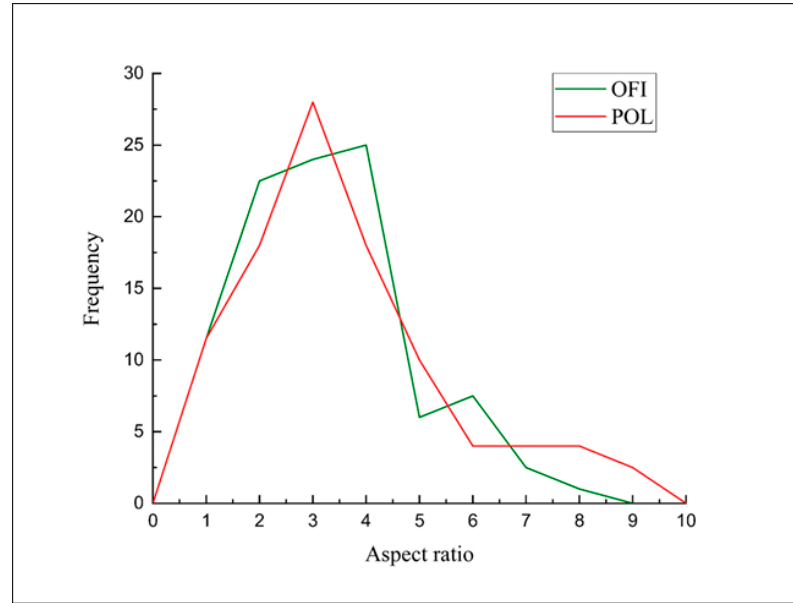
Figure 7. Size distribution of POL and OFI fillers, before processing.